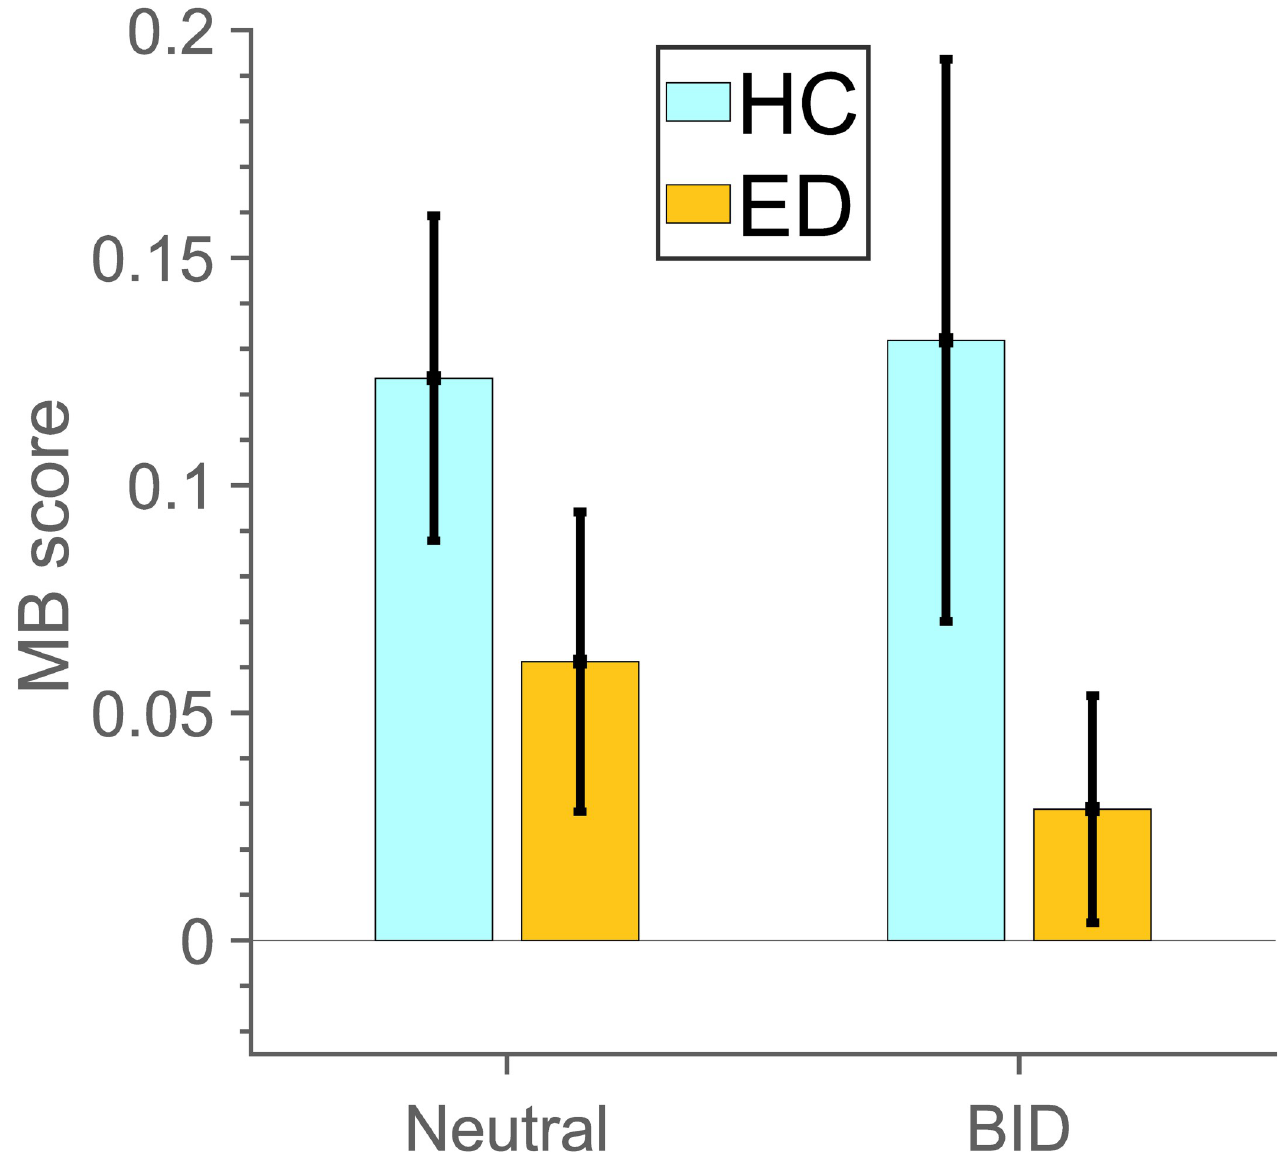
Fig 5. MB scores per group and condition in collected